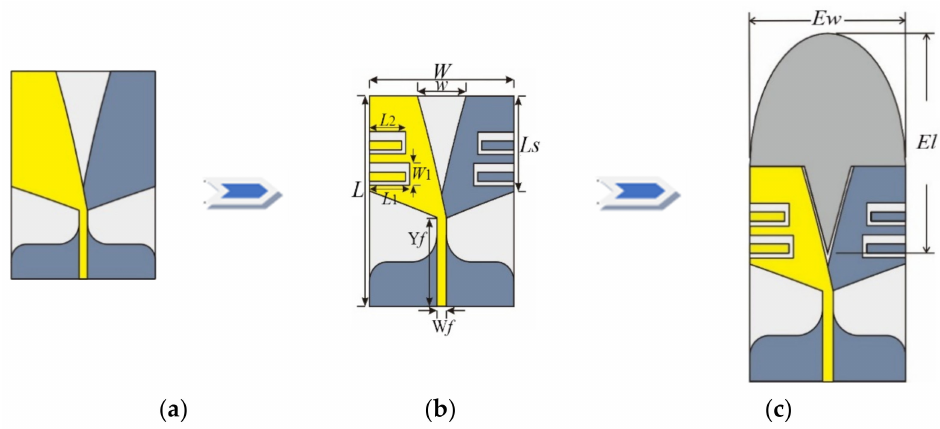
Figure 1. Evolution process of a dielectric lens director introduced into the antipodal TSA: ( a ) traditional antipodal TSA front and back views of the structure in yellow and blue, respec- tively; ( b ) two tapered U-typed slots were introduced, and ( c ) a dielectric lens director, called a